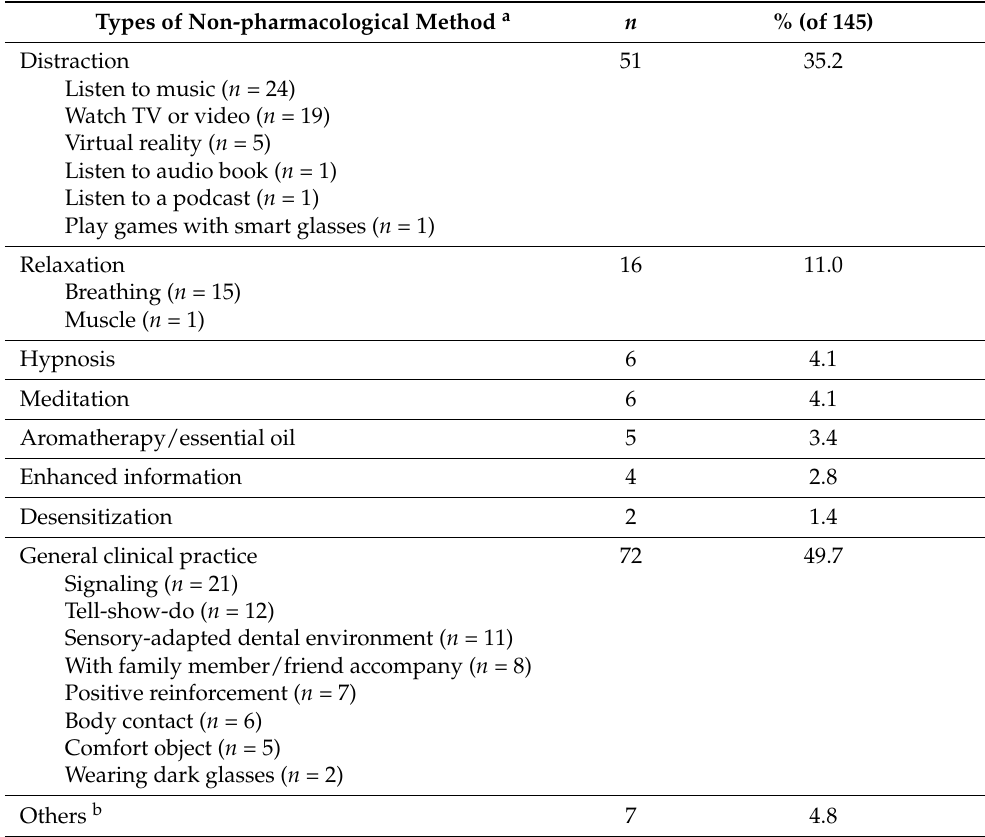
Table 8. Types of non-pharmacological method mentioned in the videos.